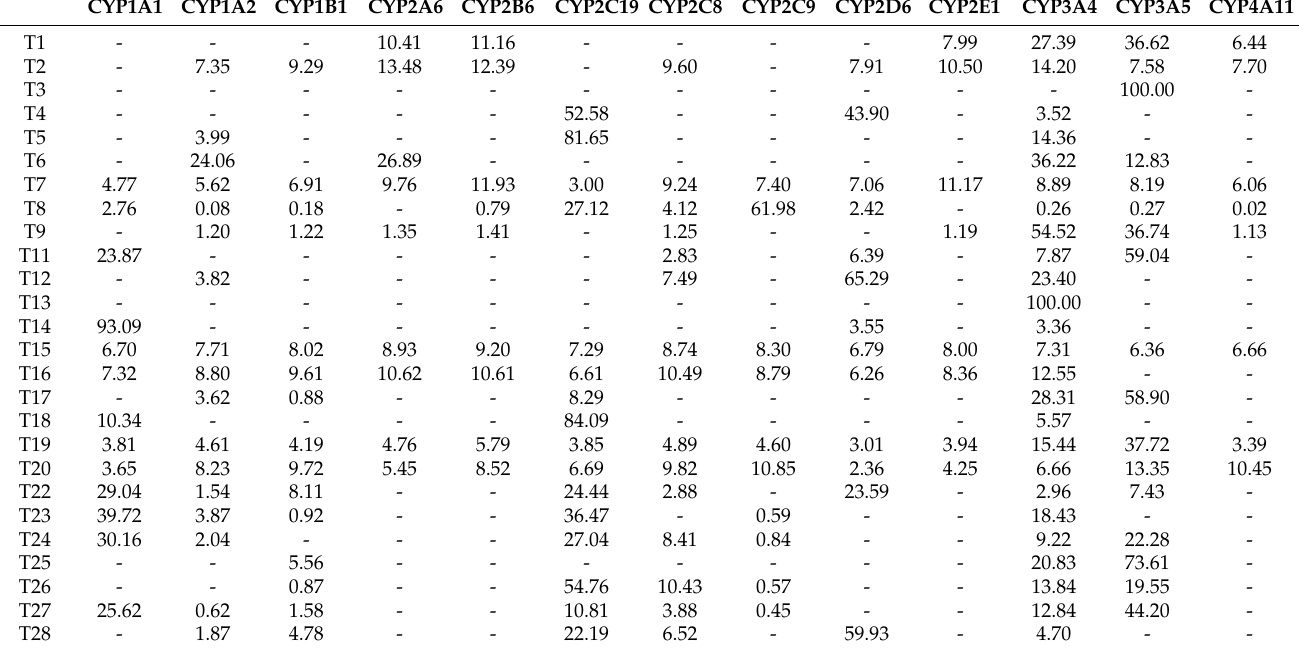
c-DNA-expressed CYPs (Control, CYP1A1, CYP1A2, CYP2B6, CYP2C19, CYP2C8, CYP2C9, CYP2D6, CYP2E1, CYP3A4, CYP3A5, CYP4A11) were used to detect the roles of individual CYPs in the metabolism of THC.